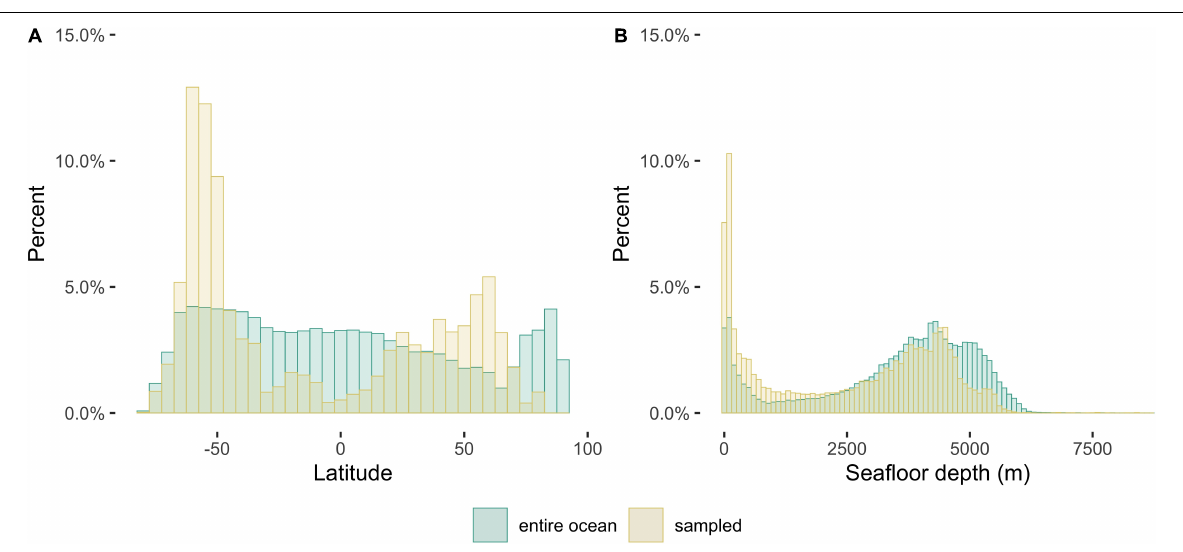
FIGURE 3 | Histograms of latitude (A) and seafloor depth (B) for the global ocean area (“entire ocean”) compared with areas sampled by observing programs in this study (“sampled”). Results include the spatial information from the surveyed programs and the datasets from the Ocean Biodiversity Information System (OBIS) and the Global Biodiversity Information System (GBIF). Bin widths are 5 degrees for latitude (A) and 100 meters for seafloor depth (B) . Regions that were under sampled are characterized by the entire ocean (blue bars) being greater than the sampled areas (gold bars), with the converse for oversampled